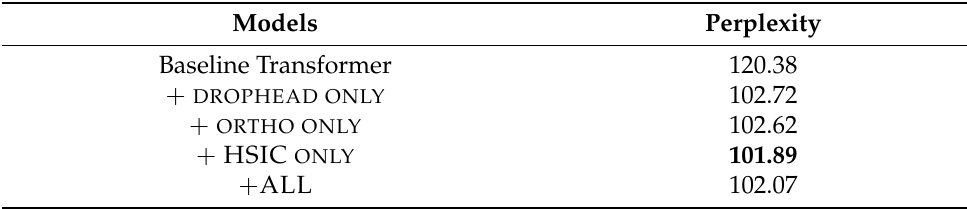
Table 7. Perplexity with controlled inter-head similarity on PTB language